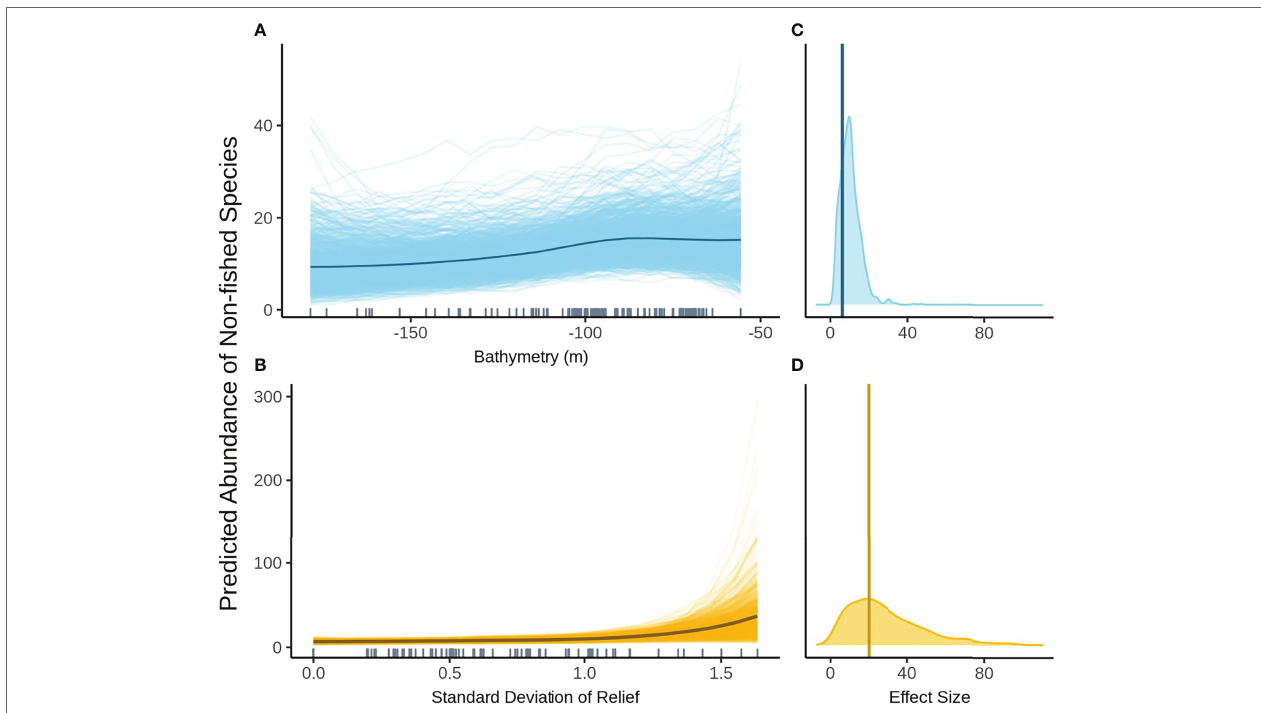
FIGURE 8 | Predicted values for the top ranked model for the abundance of non-fished species when field of view variables were included - (A) bathymetry (m), (B) standard deviation of relief. Density plots of effect size are also plotted for each aforementioned predictor – (C, D) respectively – with a vertical line indicating the frequentist effect size